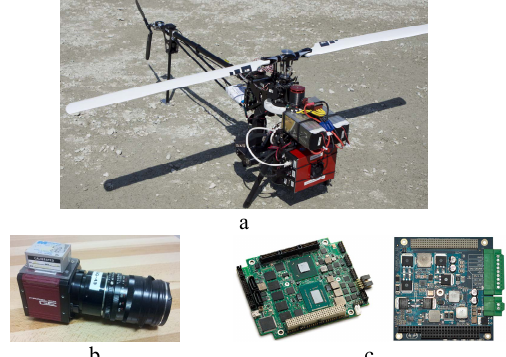
Figure 1. The aerial system, a) platform, b) sensors, c)